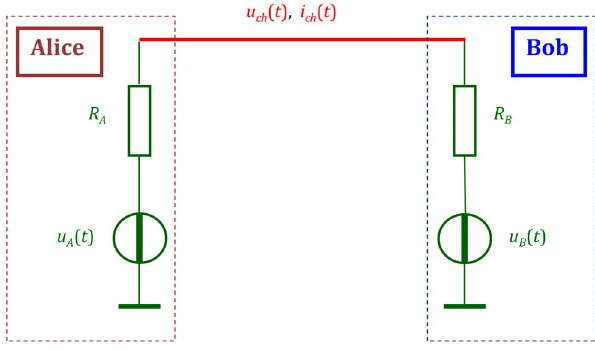
Figure 1. Outline of the core KLJN secure exchange scheme [ 2 – 4,28 ] without the defense elements against active (invasive) attacks or attacks utilizing non-ideal components and condi- tions. R A , u A ( t ) , R B , and u B ( t ) are the resistor values and noise voltages at Alice and Bob, respectively. u ch ( t ) and i ch ( t ) are channel noise voltage and current, respectively.